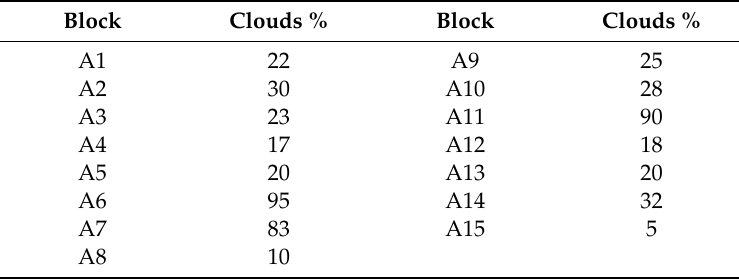
Table 2. Cloud cover percentages per block.